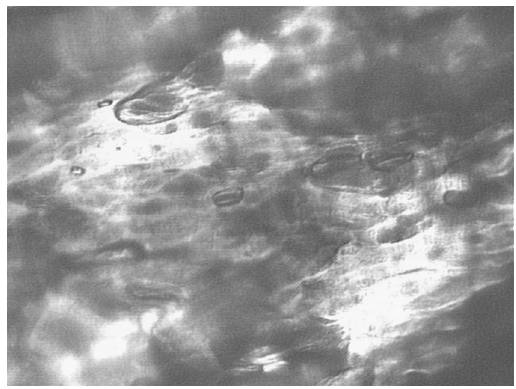
Figure 1. Birefringence observed in liquid crystals formed from Renex-100 TM .